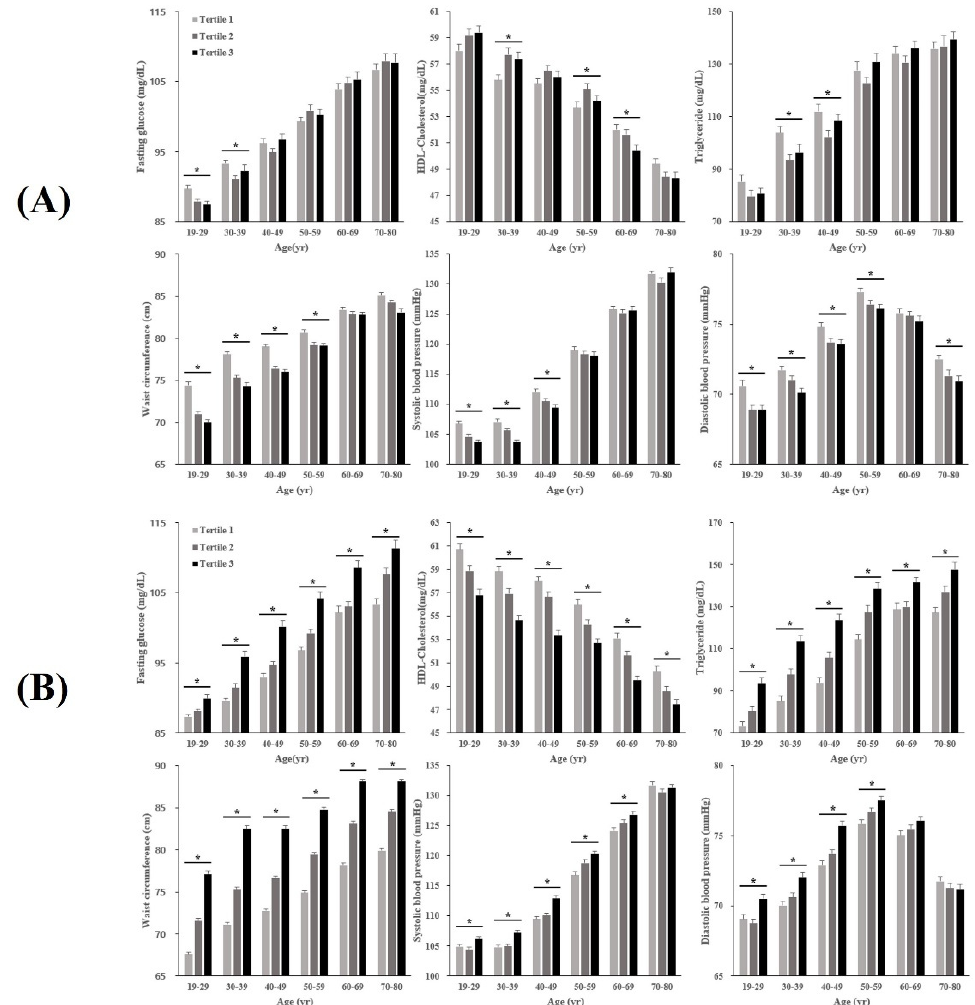
Figure 3. Metabolic syndrome components across absolute ( A ) and relative ( B ) handgrip strength tertiles in women, stratified by age. Note: Note: T1 (first tertile), highest; T2 (second tertile), intermediate; T3 (third tertile), lowest. * p -value tests for a difference between groups by handgrip strength tertile using ANOVA ( p < 0.05). Abbreviations: HDL-C, high-density lipoprotein-cholesterol. Table 2. Association between tertiles of handgrip strength and the prevalence of metabolic syndrome in males, stratified by